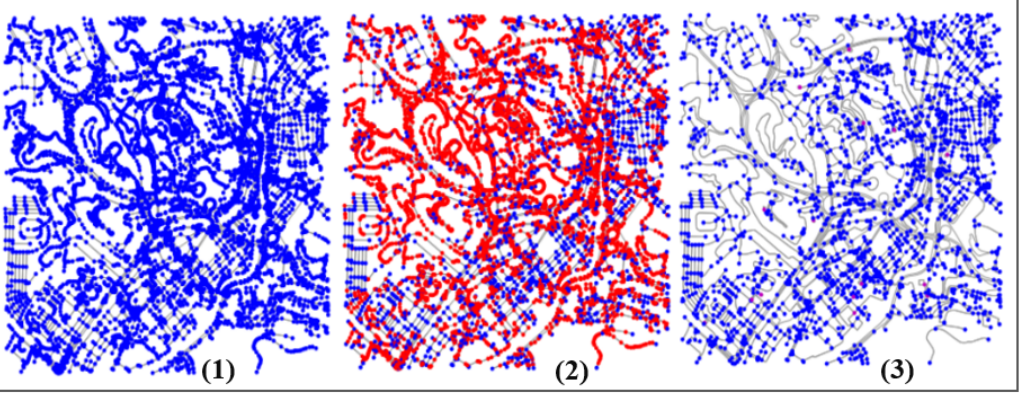
Figure 3. The simplification and correction of nodes of Kuala Lumpur within a 1.5 km bu ff er: ( 1 ) the Figure 1. Scheme of the experimental procedure. extracted SNs, ( 2 ) number of red nodes to be removed, and ( 3 ) number of nodes and cul-de-sacs after